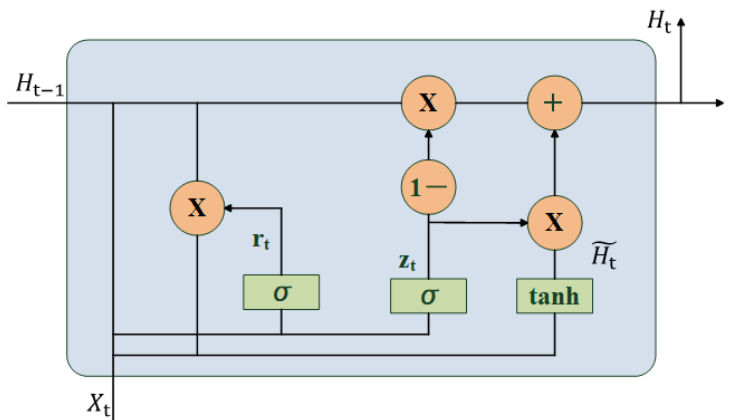
Figure 9. GRU basic